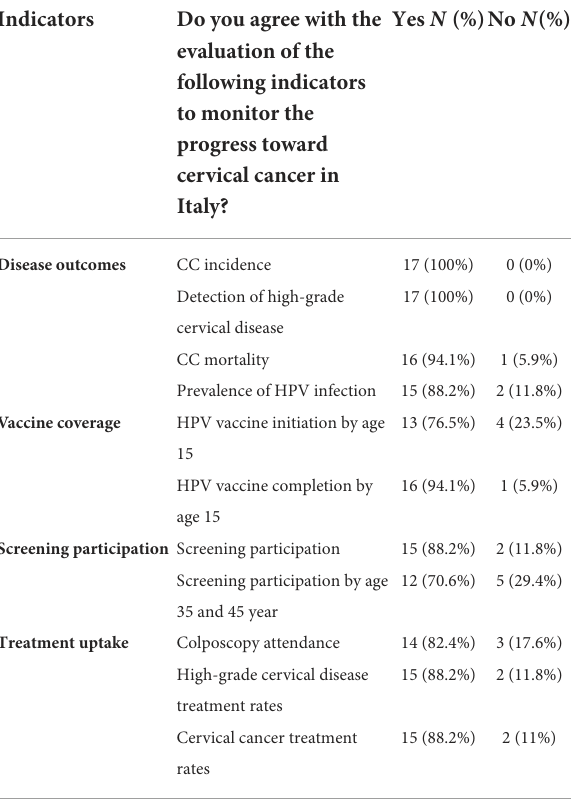
TABLE 4 Evaluation of the Italian experts regarding the 11 indicators to be used to monitor the interventions to be implemented for the CC elimination in